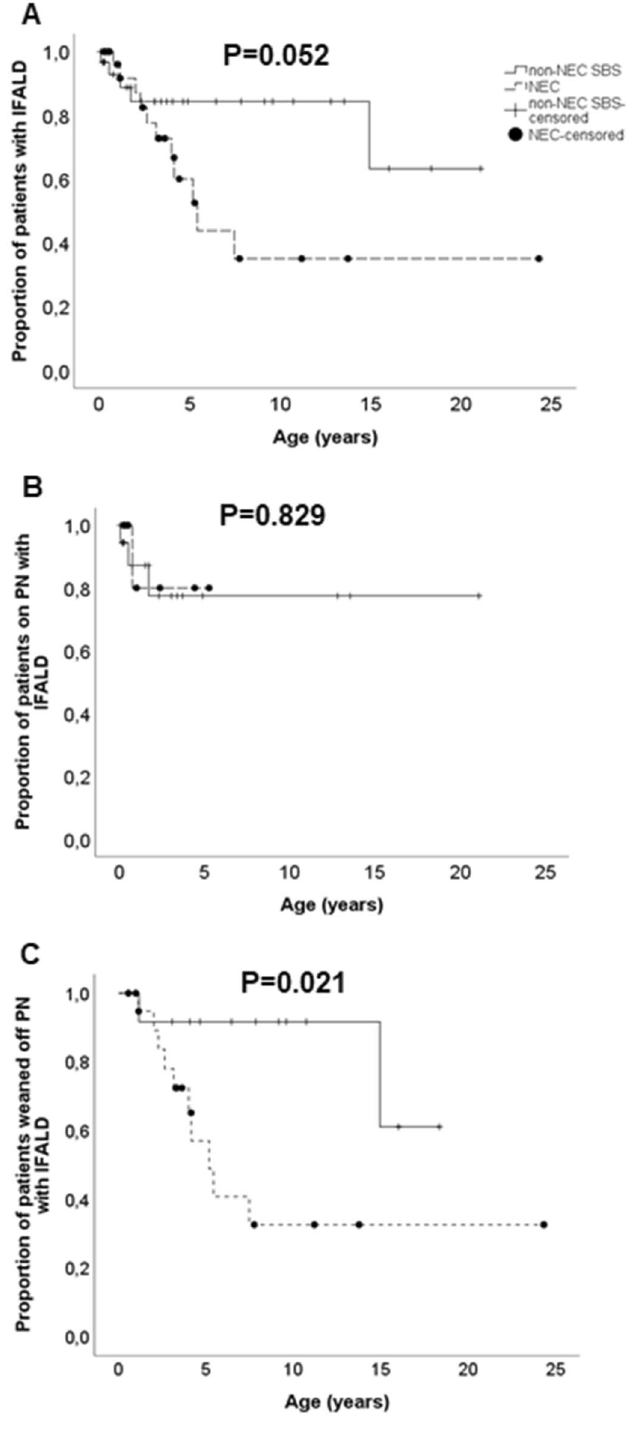
Figure 2. Cumulative proportion of patients with histological IFALD in NEC (n = 31) and non-NEC (n = 31) group. ( A ) All patients, ( B ) Patients currently on PN, ( C ) Patients who had weaned off